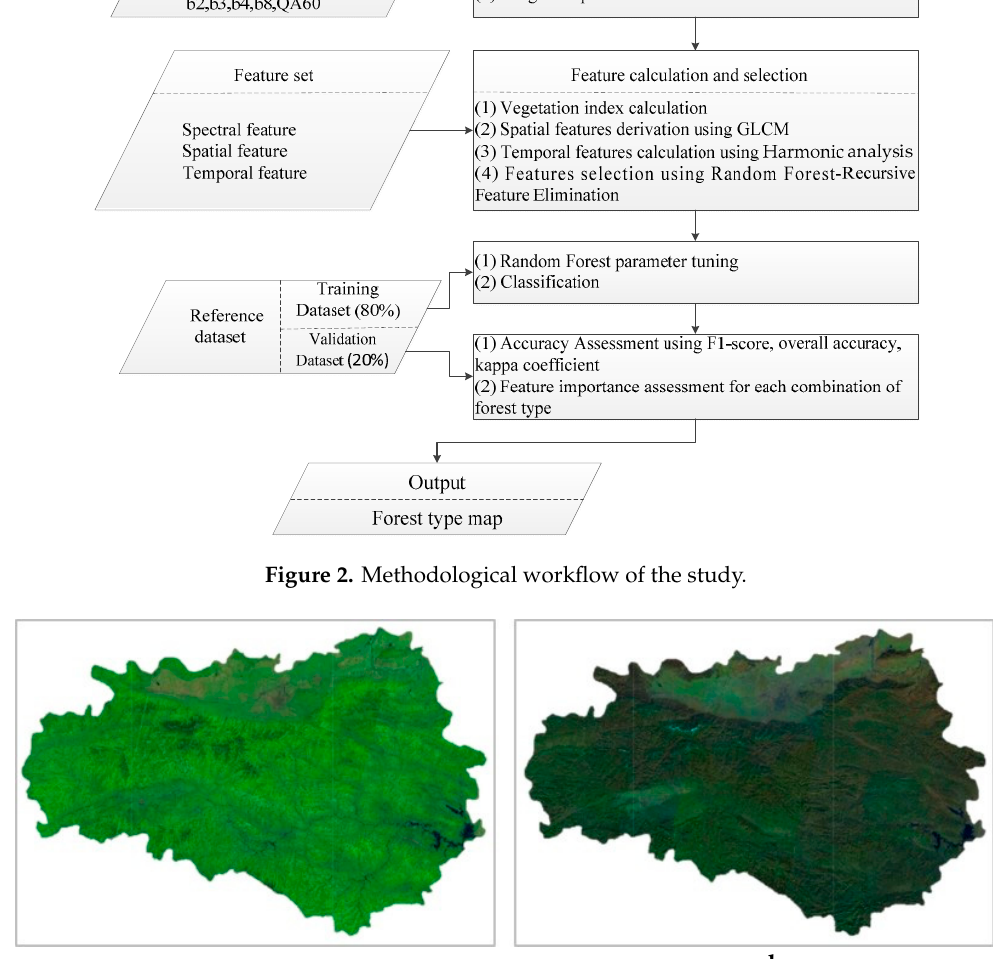
Figure 2. Methodological workflow of the study.